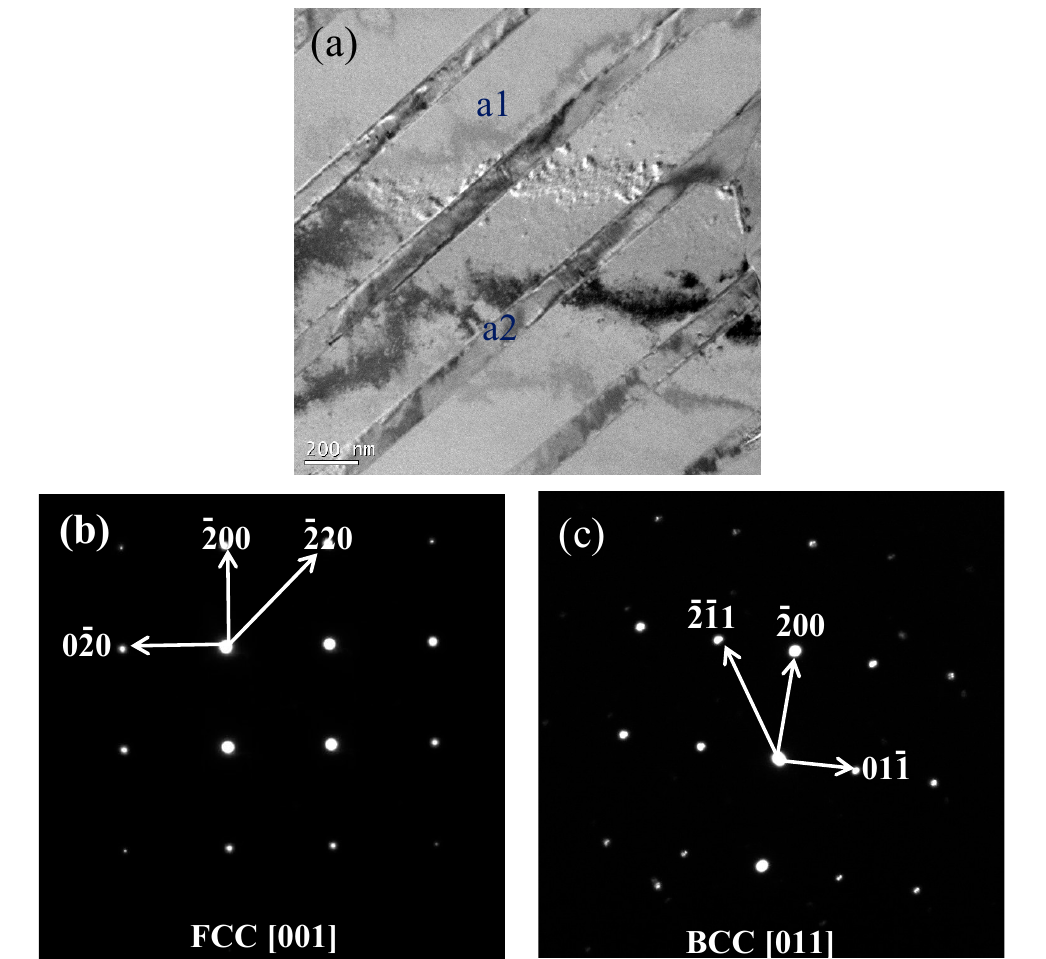
Figure 3. TEM images of the laser-remelted AlCoCrFeNi 2.1 HEA: ( a ) the morphology of the two phases; ( b ) SADPs of the FCC phases; ( c ) SADPs of the BCC phases.